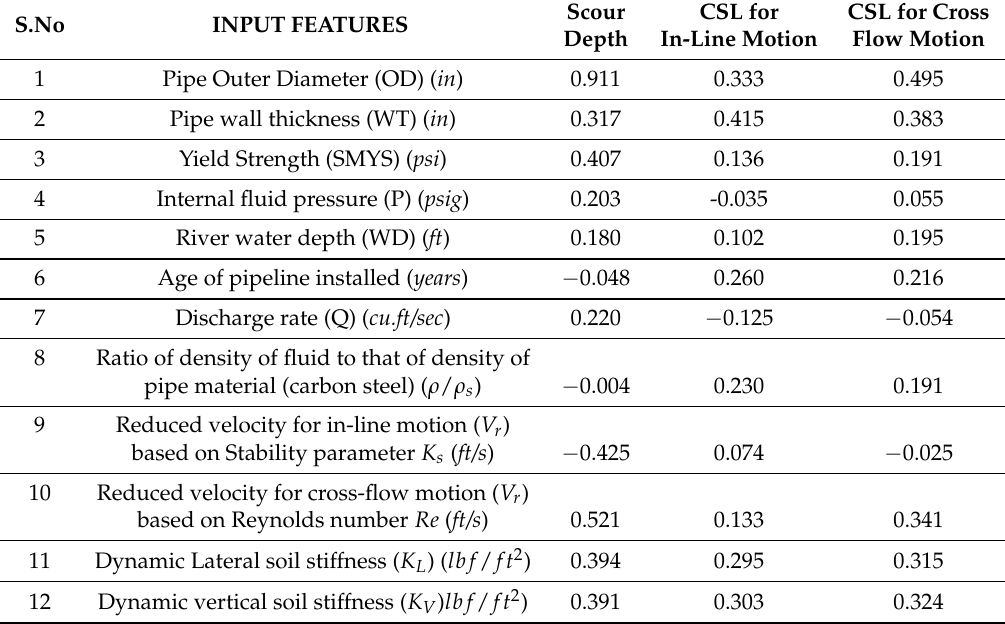
Table 3. Correlation between Input and Output